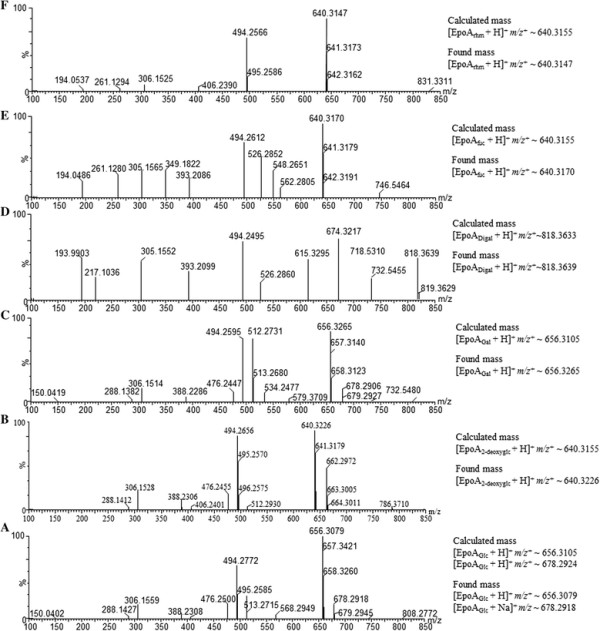
The UPLC-PDA coupled with HR-QTOF ESI-MS analysis. Different epothilone A glycosides presenting their respective mass in reference to the aglycon mass [EpoA + H]+m/z+ ~ 494.2576 are as follows: (A) Epothilone A 7-O-β-D-glucoside [EpoAGlc + H]+ m/z+ ~ 656.3079, (B) Epothilone A 7-O-β-D-2-deoxyglucoside [EpoA2-deoxyglc + H]+m/z+ ~ 640.3226, (C) Epothilone A 7-O-β-D-galactoside [EpoAGal + H]+m/z+ ~ 656.3265, (D) Epothilone A 3, 7-O-β-D-digalactoside [EpoADigal + H]+m/z+ ~ 818.3639, (E), Epothilone A 7-O-β-D-fucoside [EpoAfuc + H]+m/z+ ~ 640.3170 and (F) Epothilone A 7-O-β-D-rhamnoside [EpoArhm + H]+m/z+ ~ 640.3147.